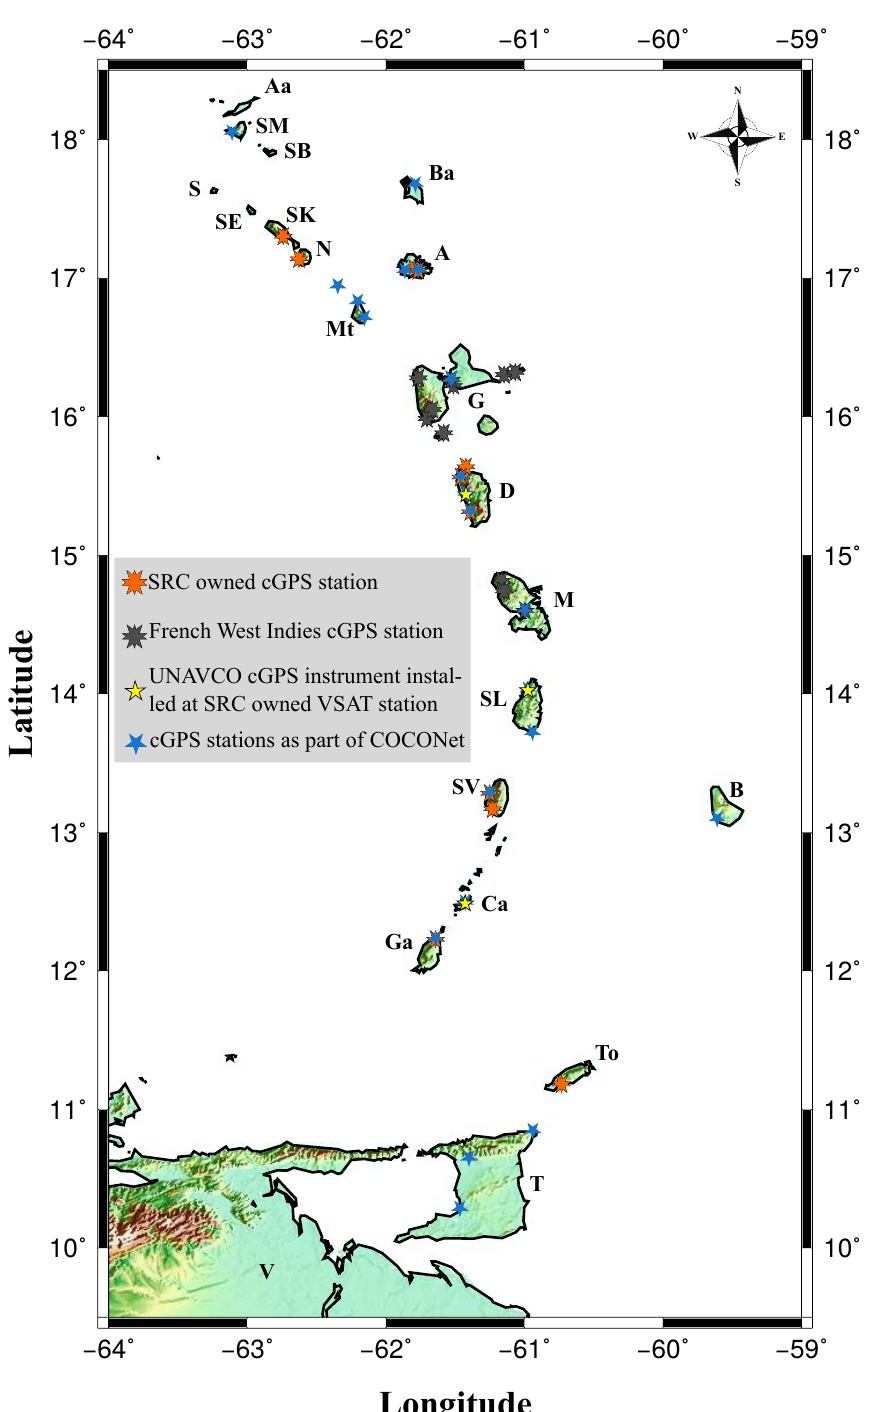
Figure 12. Location of the 11 SRC owned cGPS stations at volcanic islands (D, G, Ga, M, N, SK, SL, SV) and non volcanic islands (To, Ca, A). Green star indicates French West Indies cGPS stations of the Guadeloupe volcano observatory and the Martinique volcano observatory, both operated by the IPGP. Yellow star indicates the location of a UNAVCO cGPS installed at an SRC-owned VSAT seismic station. Blue star indicates stations from SRC, IPGP and UNAVCO which contribute to UNAVCO’s Continuously Operating Caribbean GPS Observational Network (COCONet). A: Antigua; B: